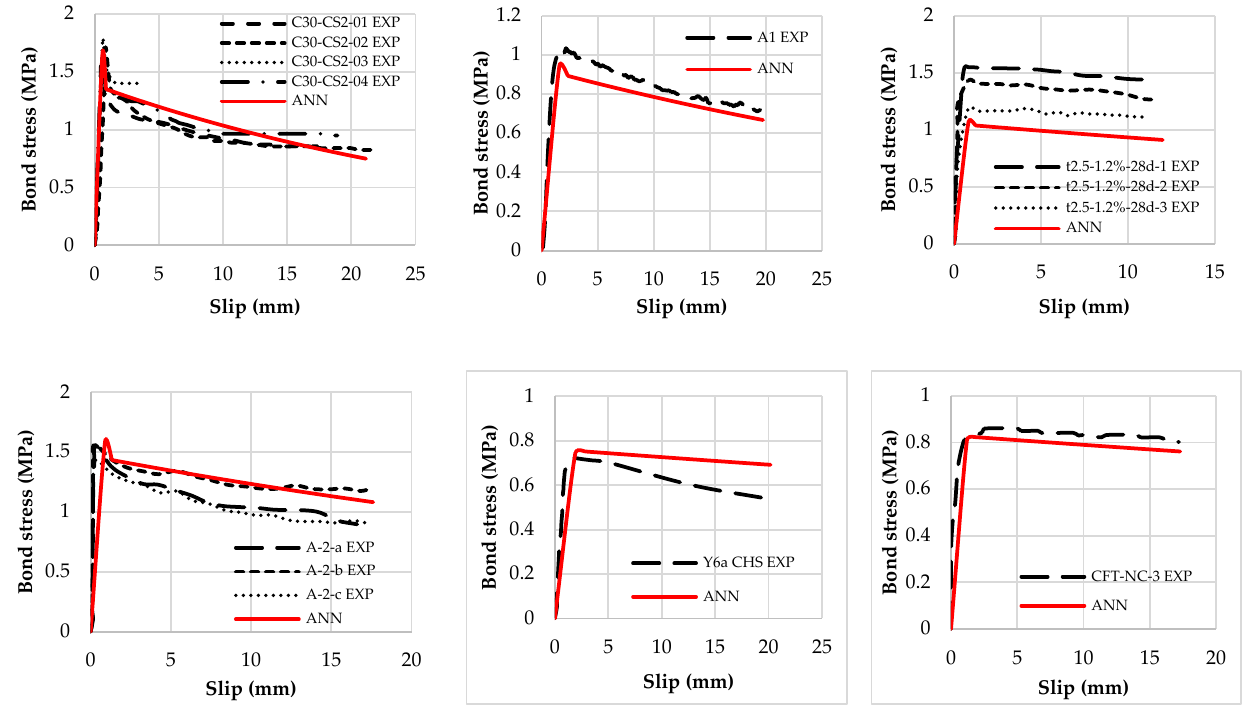
Figure 9. Experimental versus predicted interfacial behavior using ANN of circular specimens.